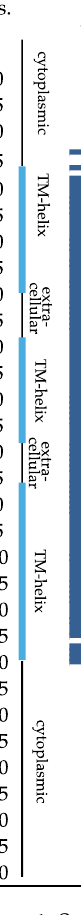
Figure 1. Solid-state NMR backbone assignments of KcsA in liposomes as described by the McDer- mott Group (*) [3,26,33,34] or Baldus Group (†) [28,35,36]. Structural regions are indicated to the right of residue numbers.